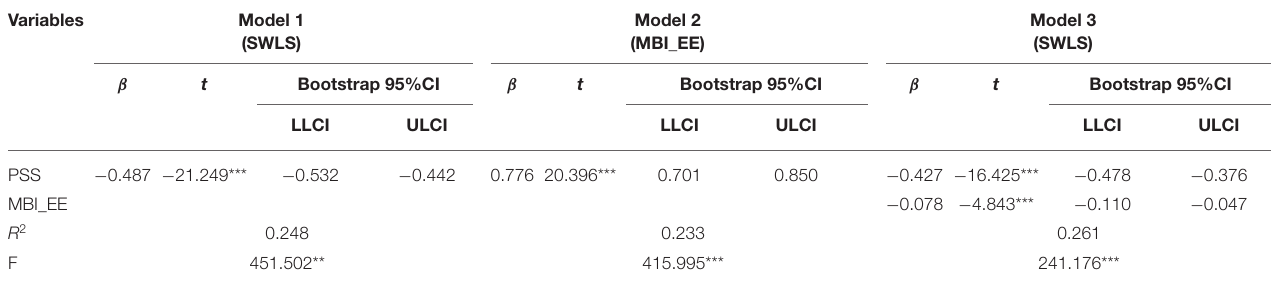
TABLE 2 | Mediation analysis ( n = 1,372).